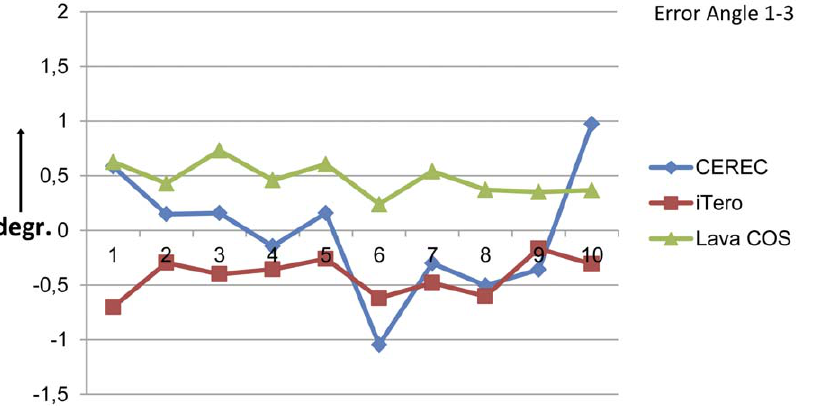
Figure 9. The angulation errors between the cylinders 1 and 3 in degrees for the three intra-oral scanners. The angulation errors were small and ranged from 2 0,1447 u (CEREC) to 1,0456 u (CEREC). The iTero showed the smallest mean angulation error. The Lava COS showed the smallest variations. The Lava COS showed only positive errors, while the iTero showed only negative errors. Only the Lava COS showed consistent positive errors in all cases, this could be regarded as an offset which may be